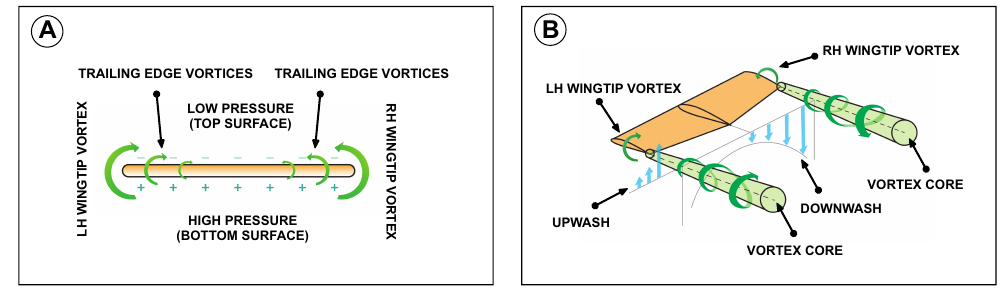
Figure 3. ( A ) Illustration of lift generation due to pressure imbalance and its associated wingtip and trailing edge vortices; ( B ) Illustration of wingtip vortices rotation and the associated downwash and